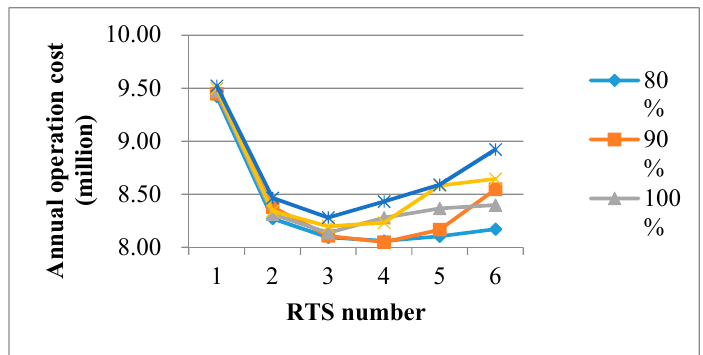
Figure 6. Sensitivity analysis of the fixed annual investment cost in the RTS (refuse transfer stations).